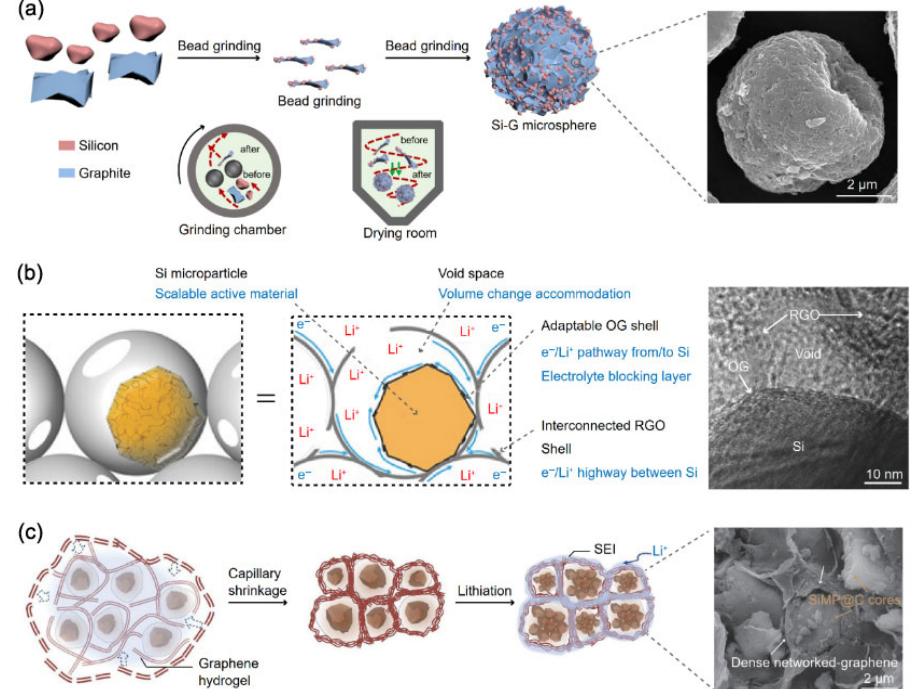
Figure 5 (a) Synthesis diagram of nanostructured Si-G microspheres through a two-step mechanical strategy. Reproduced with permission from Ref. [106], © Wiley-VCH GmbH 2022. (b) Schematic illustration for the structure of mSi@OG@RGO. Reproduced with permission from Ref. [104], © WILEY-VCH Verlag GmbH & Co. KGaA, GmbH 2018. (c) Formation of 3C architecture in SiMP@C-GN. Reproduced with permission from Ref. [105], © Chen, F. Q., et al.